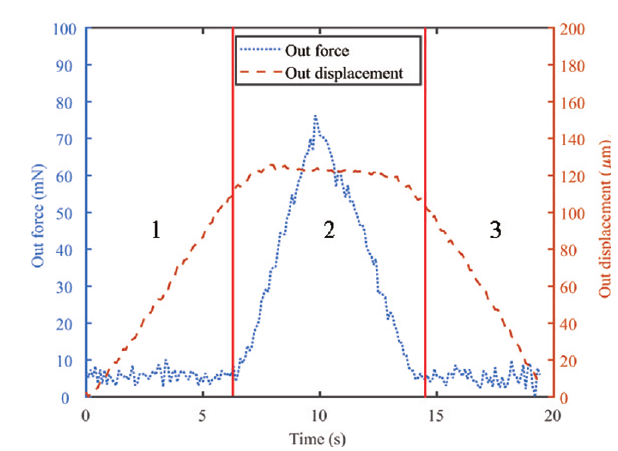
Figure 19. Experimental results of open-loop gripping process test.